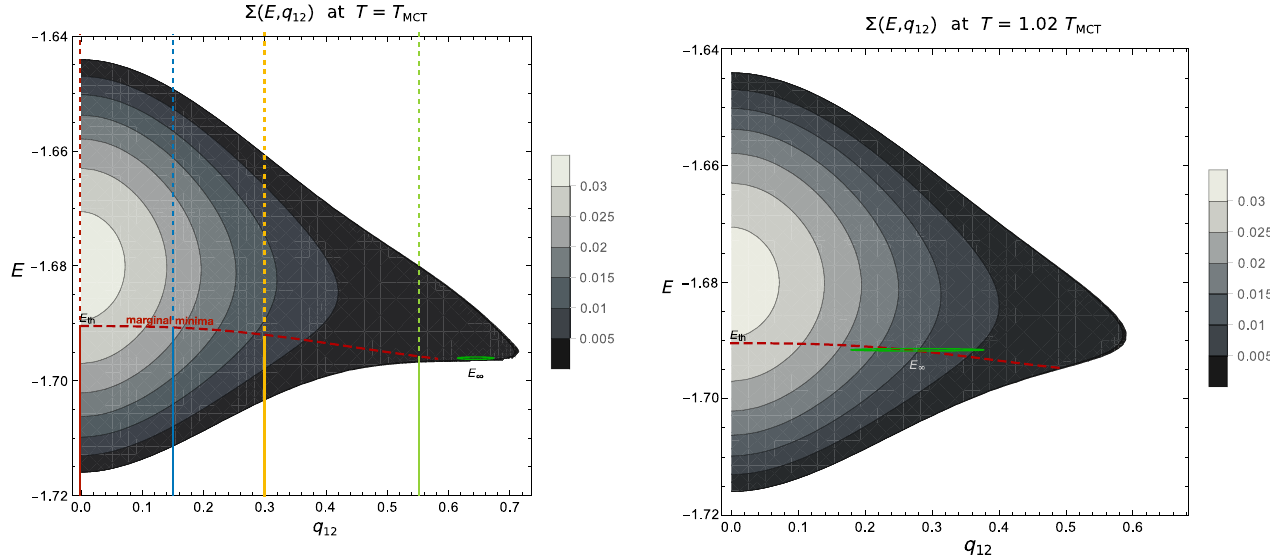
dynamics.FIG. 19. Quenched complexity of dominant states with energy E and overlap q 12 with respect to an equilibrium configuration at temperature T ¼ T (left panel) and T ¼ 1 . 02 T (right panel). In the left panel, the four colored vertical lines highlight the MCT MCT ; T complexities shown in Fig. 18. The choice of the temperature is not crucial as long as T ∈ ð T . The almost horizontal red curves SF onset Þ q mark the threshold energy E 12 Þ , and the green ellipsis is our best estimate for the large-time limit of the relaxation dynamics obtained th ð from the numerical